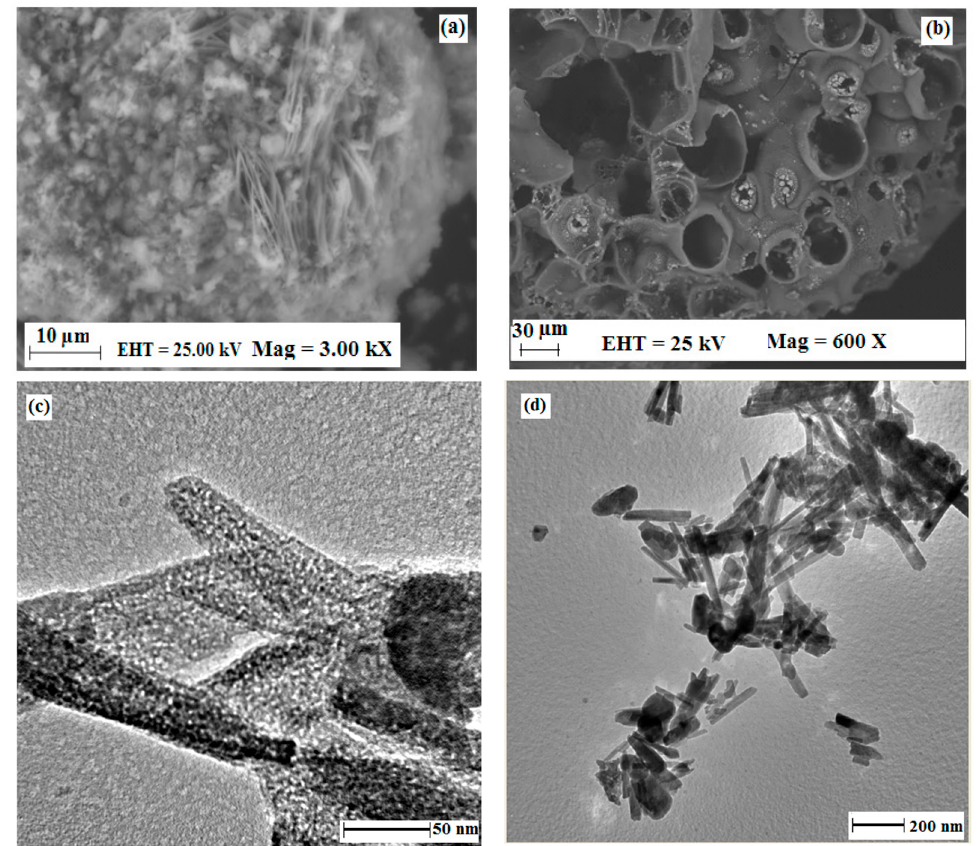
Figure 5. The SEM and TEM image. ( a ) SEM image of [Ag 0.05 ZnO 0.05 V 2 O 5(0.90) ], ( b ) SEM image of [Ag 0.05 ZnO 0.05 V 2 O 5(0.90) ] N , ( c ) TEM image of [Ag 0.05 ZnO 0.05 V 2 O 5(0.90) ], and ( d ) TEM image of [Ag 0.05 ZnO 0.05 V 2 O 5(0.90) ] N .